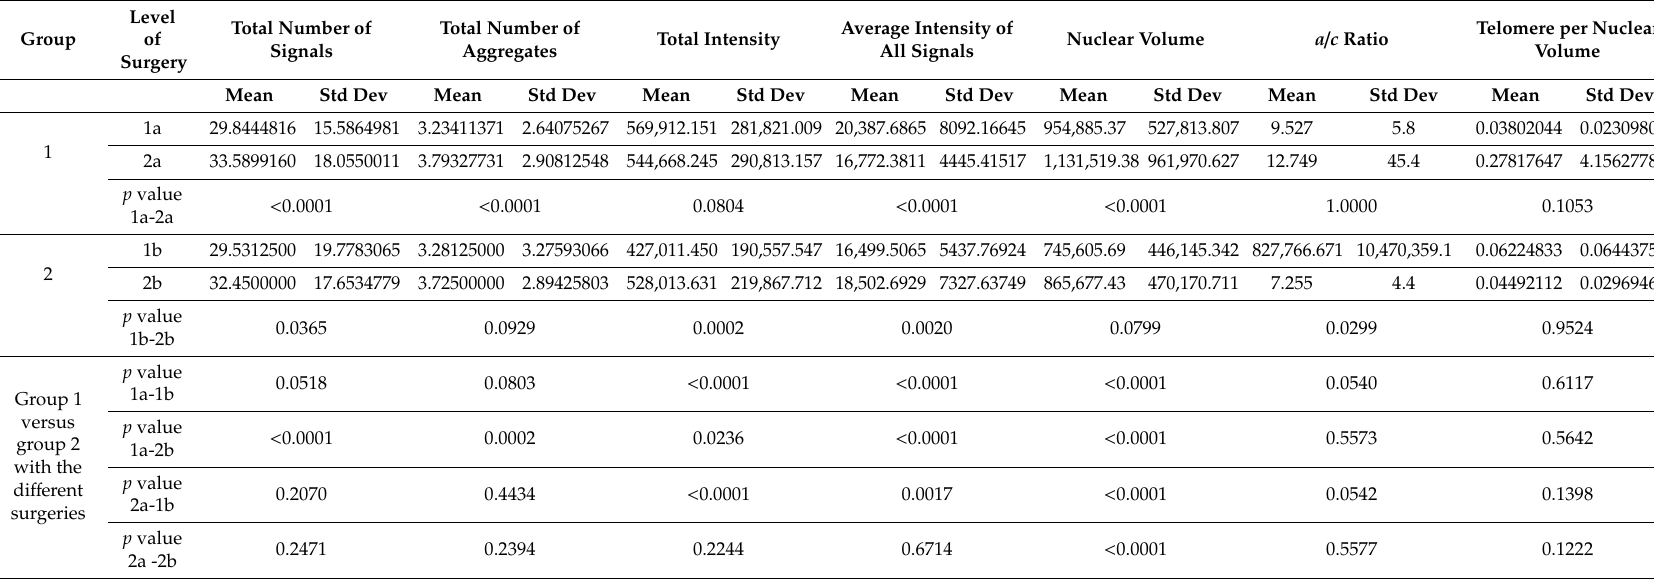
Table 2. Comparison of telomeric profile parameters per cell between the two defined